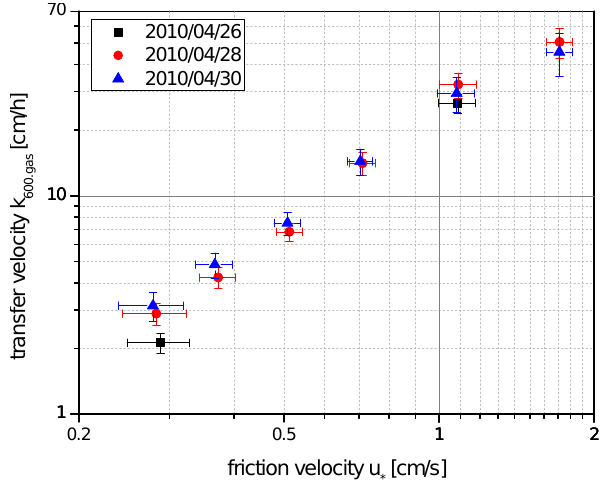
Figure 5. Measured gas transfer velocities scaled to a Schmidt num- ber of Sc = 600 plotted against the global averaged friction velocity. Dates are given in YYYY/MM/DD.